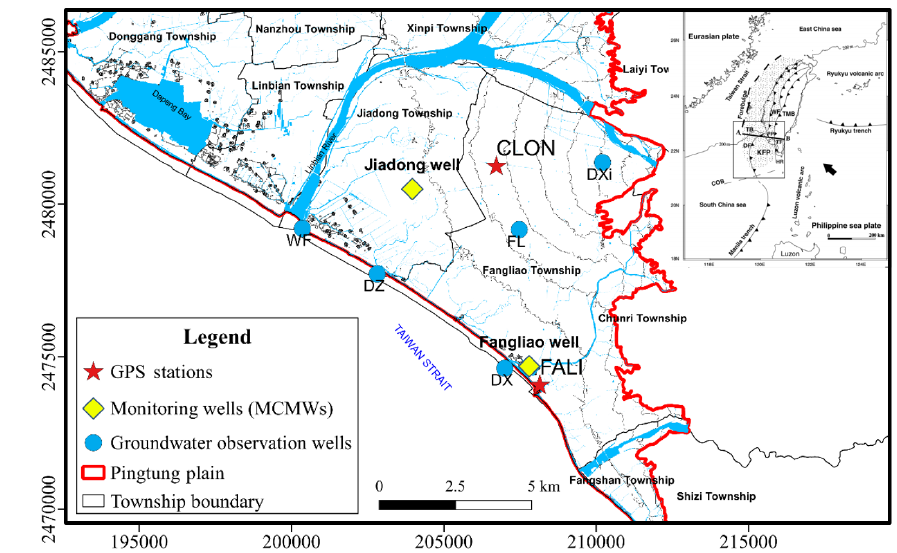
Figure 1. The distribution of monitoring system in the study area (Modified from Chiang et al.,